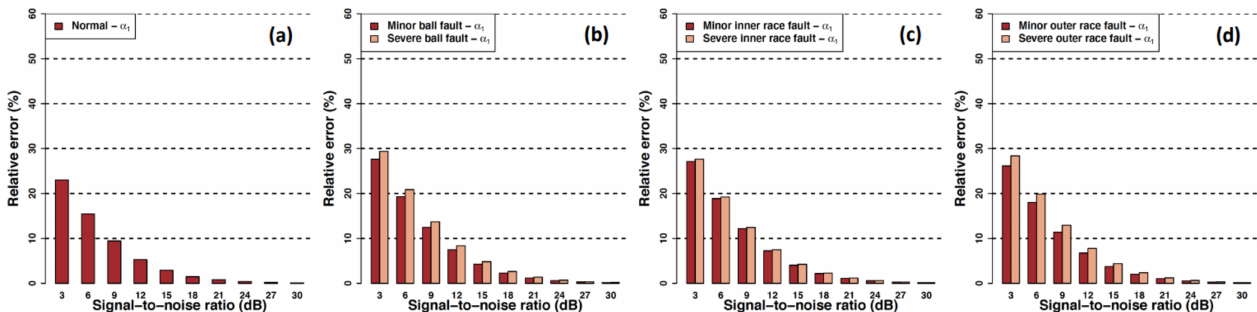
Figure 12. Relative errors in the scaling exponent ( α 1 ) due to induced noise in the bearing vibration signals: ( a ) normal, ( b ) ball fault, ( c ) inner race fault, ( d ) outer race fault.